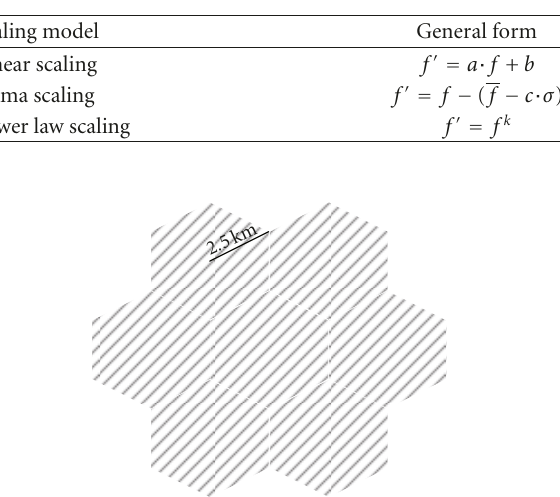
Table 1: Scaling methods.